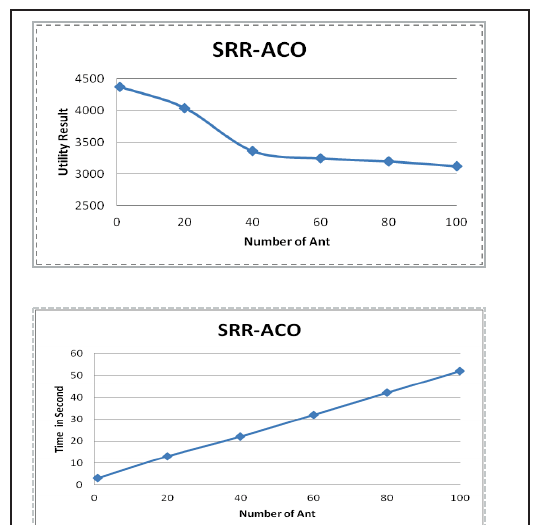
Figure 2: Time and utility related to number of ant